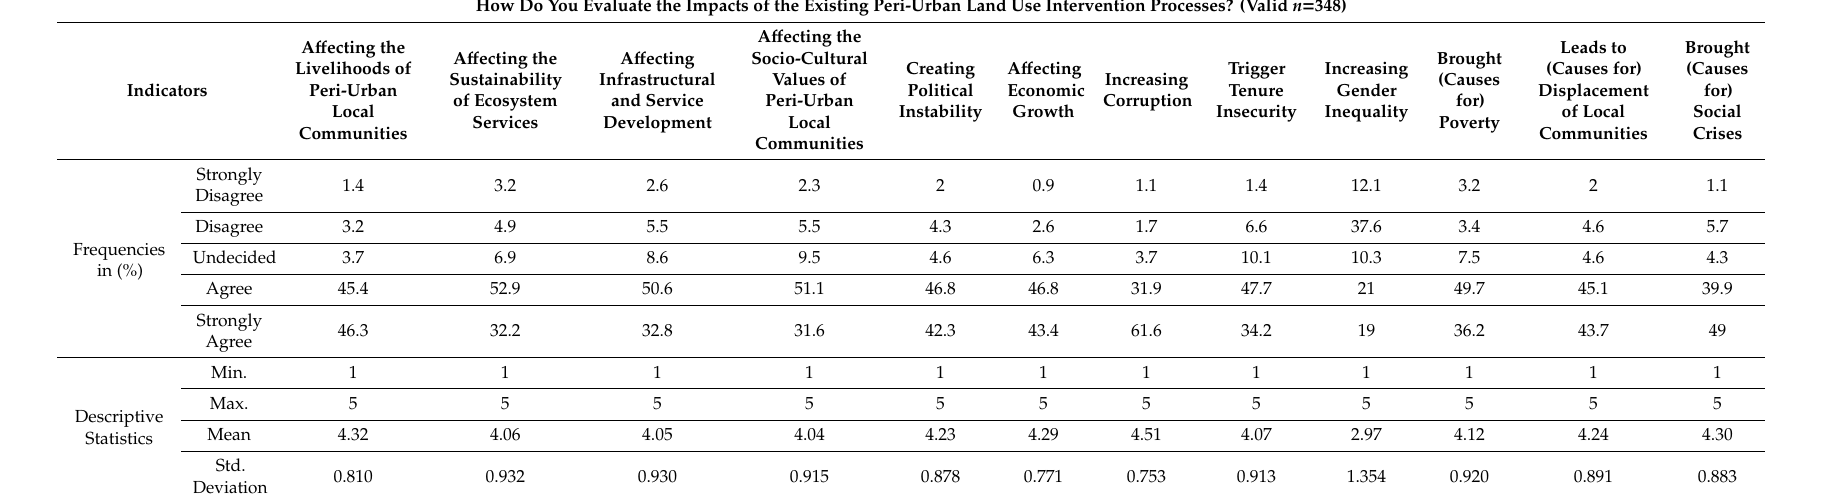
Table 6. Impacts of the existing peri-urban land use intervention